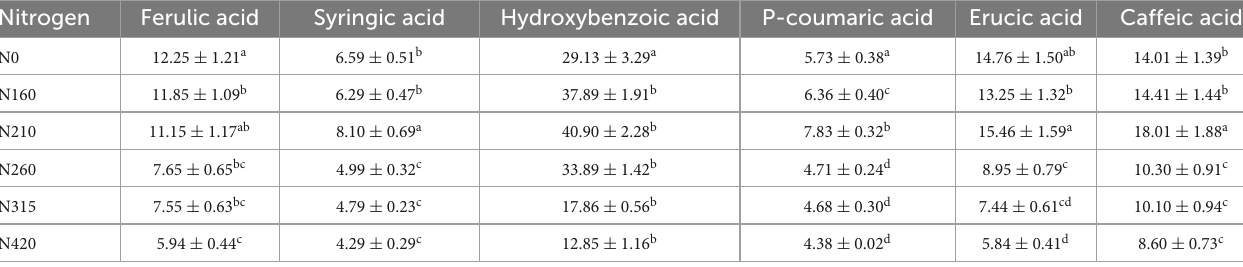
TABLE 2 Phenolic composition of brown rice.